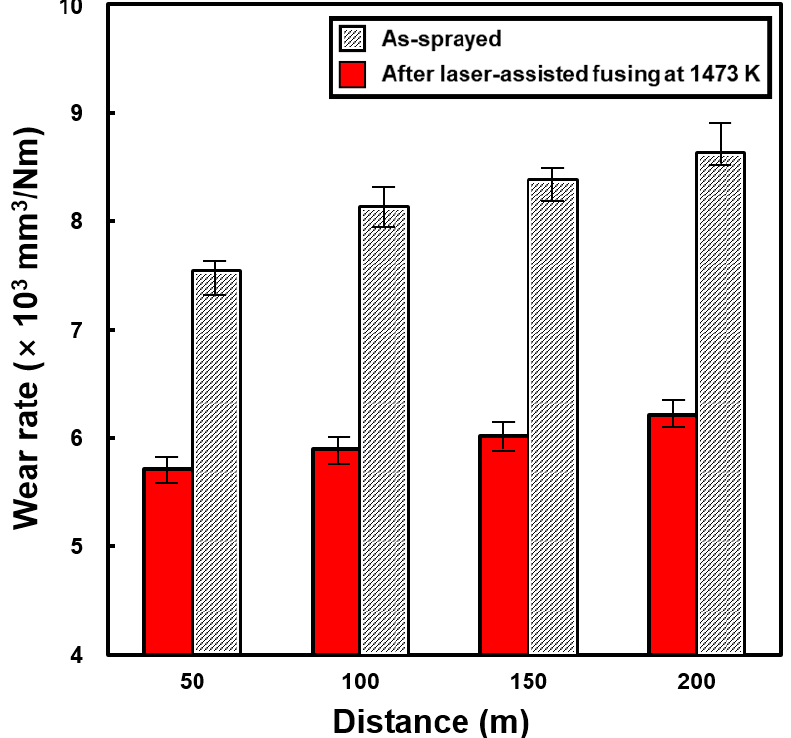
Figure 11. Comparison of average wear rate of thermal-sprayed 1276F coating and that after laser- assisted fusing at 1473